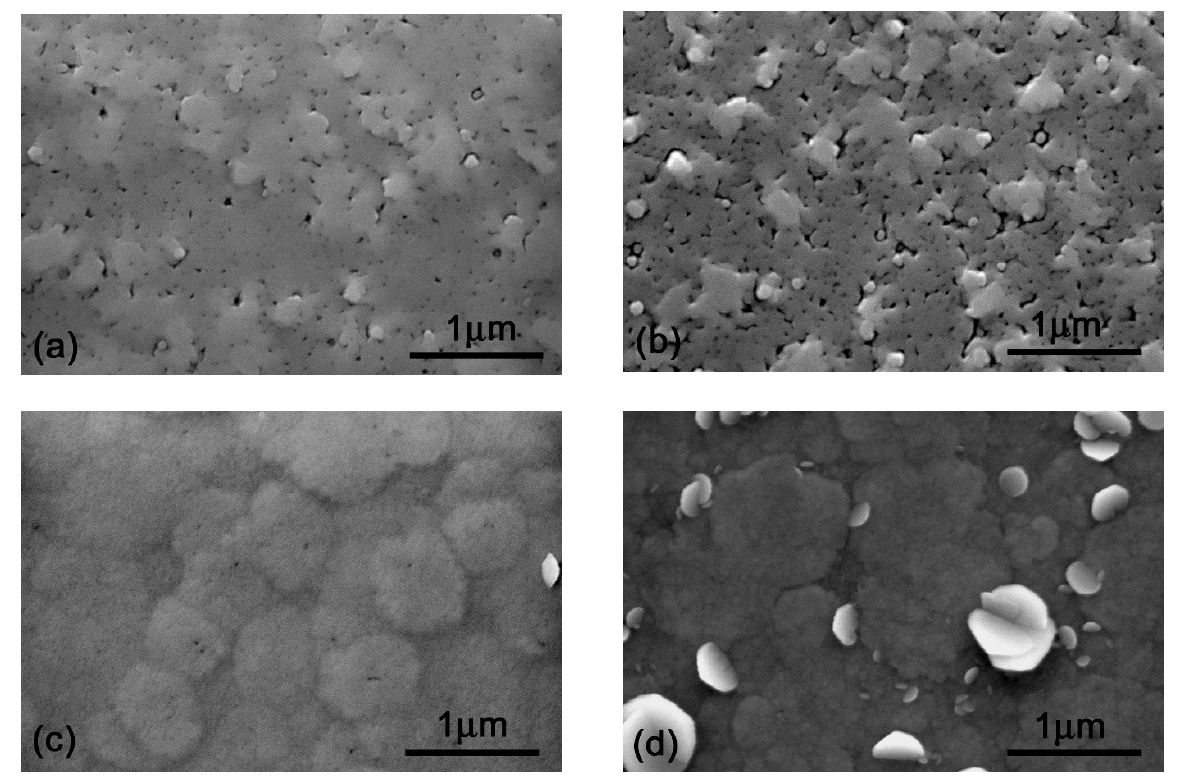
Figure 4. InAlN layers SEM analysis for Cp 2 Mg flow of ( a ) 0 nmol/min, ( b ) 30 nmol/min, ( c ) 80 nmol/min, and ( d ) 130 nmol/min.